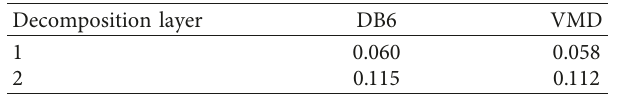
Table 5: The comparison of optimal decomposition effects between two algorithms.